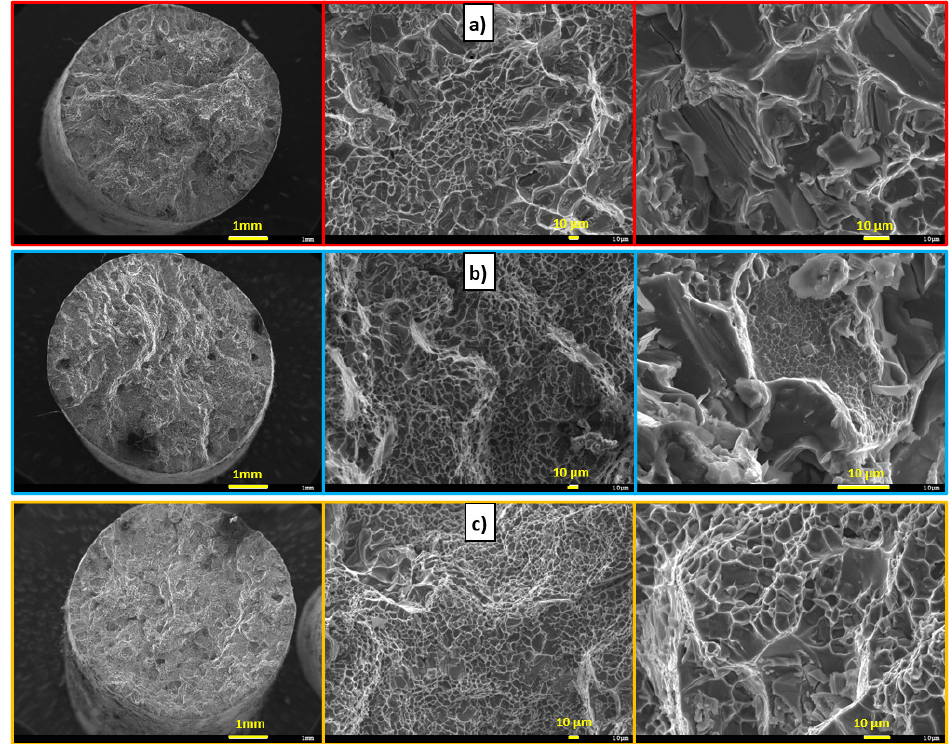
Figure 11. Macroscopic and microscopic character of fracture surfaces after heat treatment, SEM, ( a ) F1 alloy, ( b ) F2 alloy, and ( c ) F3